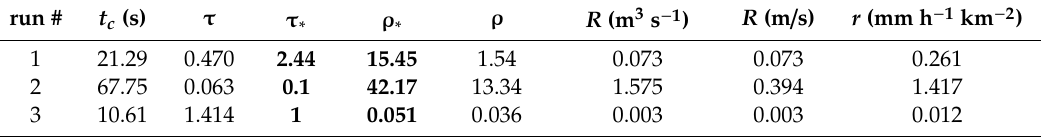
Table 6. For the three runs, derived parameters used in the suggested procedure and runo ff results. Bold values refer to τ ∗ input parameter and to ρ ∗ output parameter considered in Equations (26)–(28).